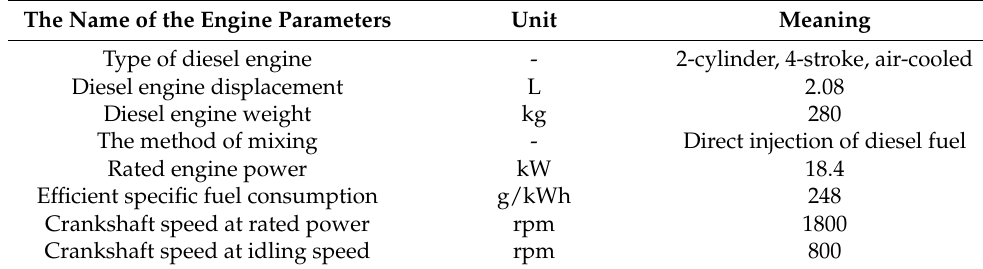
Table 3. Brief technical characteristics of the experimental diesel engine